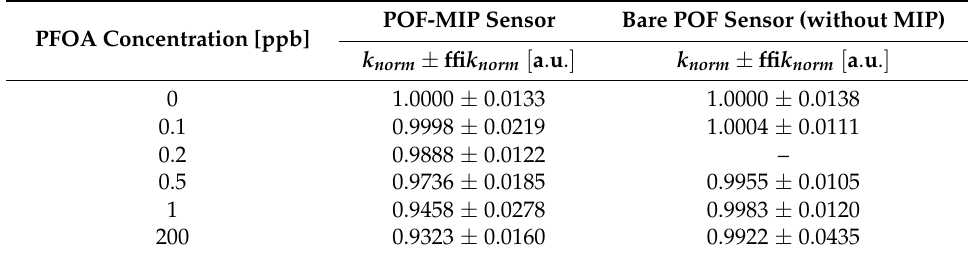
Table 1. Obtained values for the characterized sensors (with and without the MIP)-output signal normalized to 0 ppb (blank), by incubating solutions at increasing concentrations of PFOA in water solution (range 0–200 ppb).